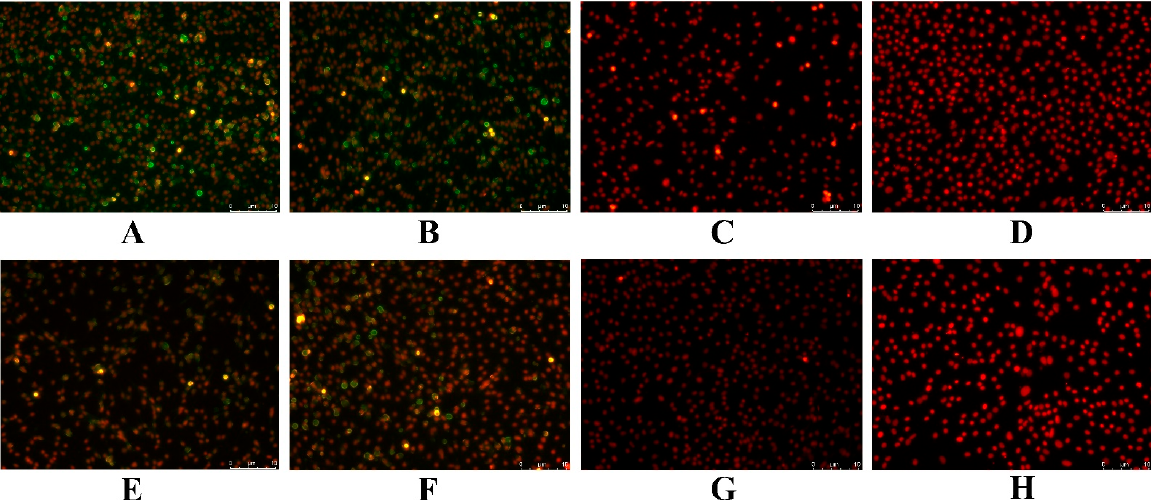
Figure 6. Indirect immunofluorescence assays for infected MSH cells. ( A ) New isolated virus infection/anti-LMBV Ab, ( B ) LMBV-GD202006 infection/anti-LMBV Ab, ( C ) LMBV-GD202006 infection/anti-MSRV Ab, ( D ) uninfected cells/anti-LMBV Ab, ( E ) New isolated virus infection/anti-MSRV Ab, ( F ) MSRV-GD201707 infection/anti-MSRV Ab, ( G ) MSRV-GD201707 infection/anti-LMBV Ab, and ( H ) uninfected cells/anti-MSRV Ab. The nuclei were stained red using propidium iodide (PI) solution. Bar = 10 µ m.